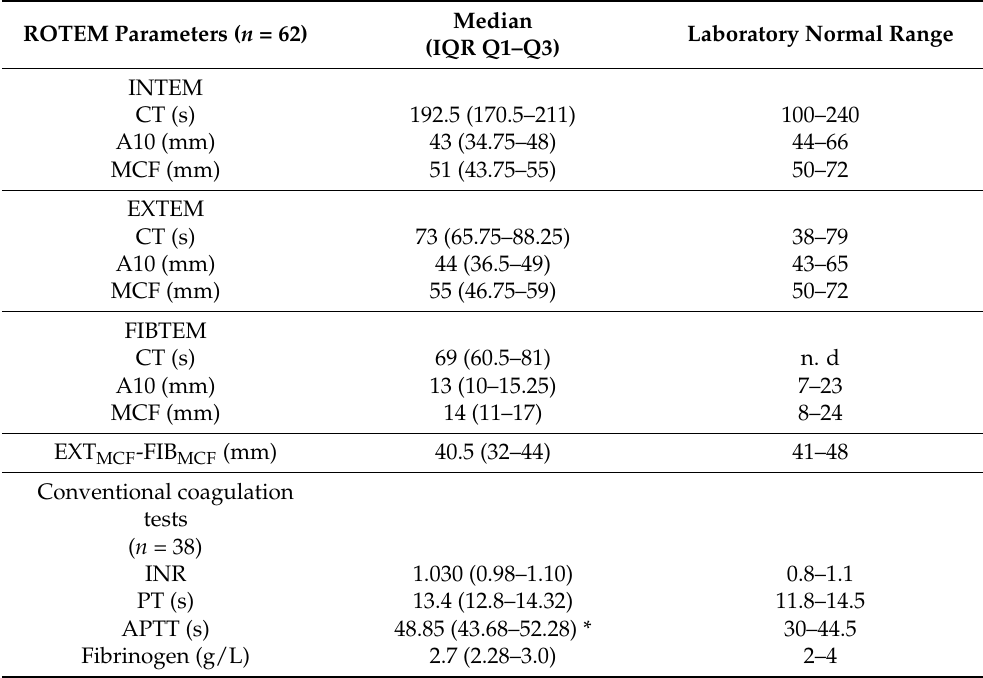
Table 2. Hemostasis characteristics of dengue patients with warning signs febrile phase at